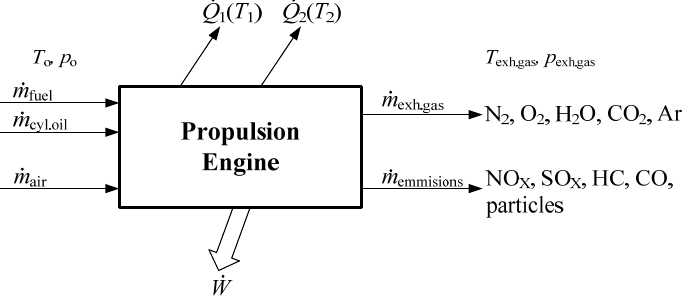
Figure 1. The propulsion engine model depicting main input and output substances and energy